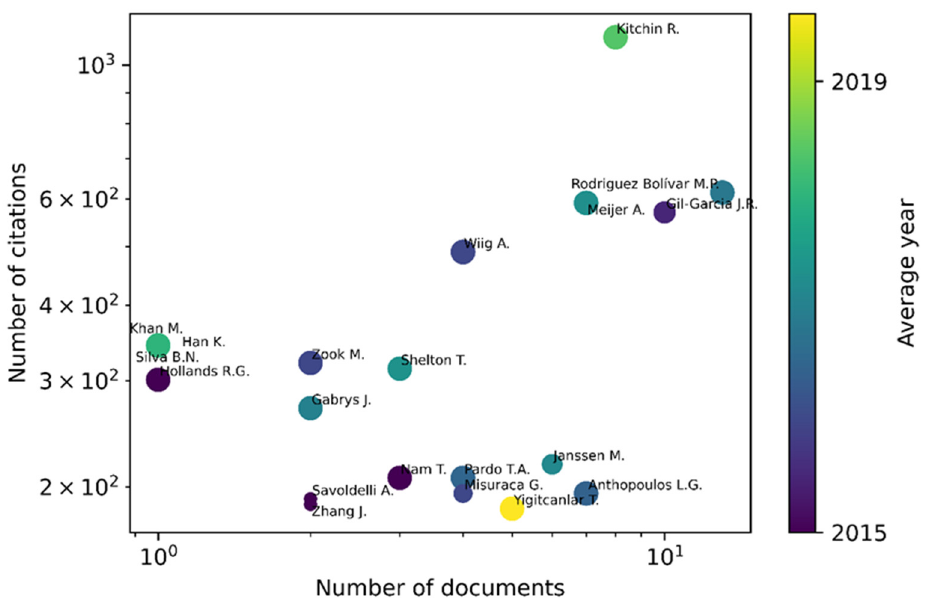
Figure 5. Most relevant authors by number of documents and citations in SPG research (1999–2021). Note: Additional information is provided by the size of a circle reflecting the share of smart city research (e.g., Savoldelli A. and Zhang J. have the smallest shares of smart city documents).